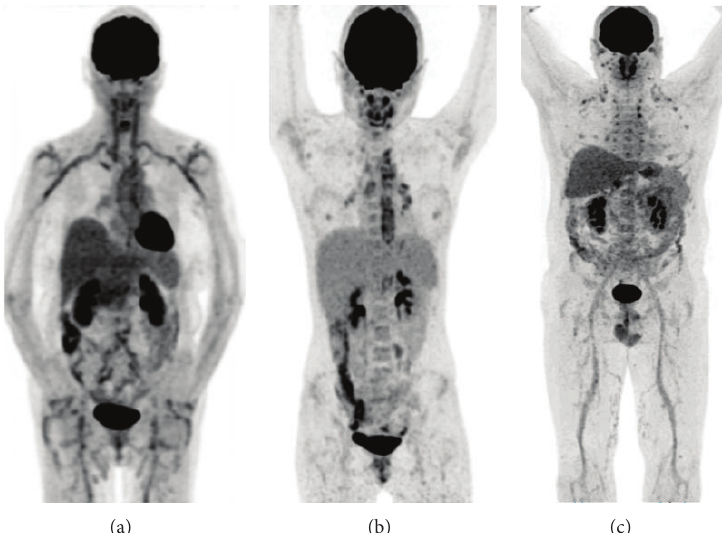
Figure 1: FDG-PET examples of vasculitis: (a) giant cell arteritis and polymyalgia rheumatica: high FDG uptake in the large vessels (aorta, subclavian arteries, carotid arteries, iliac arteries, and femoral arteries) accompanied by high uptake in the large joints (shoulders and hips), (b) Takayasu’s arteritis: high FDG uptake located more centrally (aorta and main branches in the thoracic region) and in this case uptake in reactive lymph nodes in mediastinum and hili (confirmed by biopsy), and (c) polyarteritis nodosa and polychondritis: high uptake in the medium- and small-sized arteries (best visible in the legs) accompanied by uptake in the nose, the ears, and the costochondral